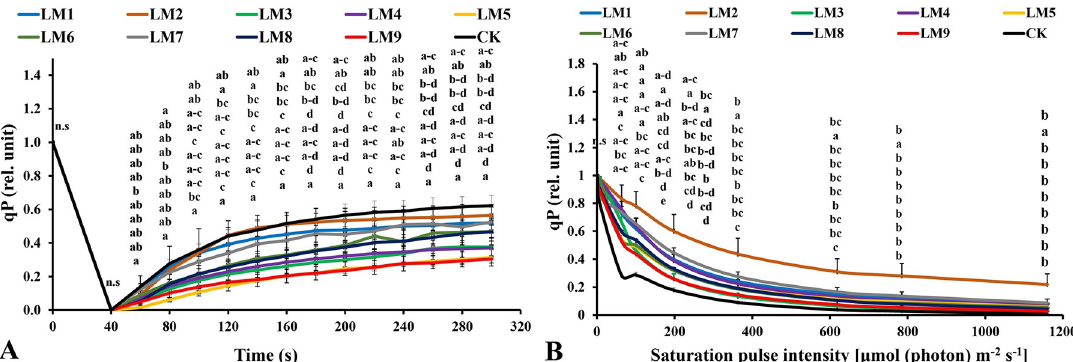
Fig 10. Effects of LED light modes on chlorophyll a fluorescence induction kinetics of the dark-acclimated (A) and RLC of the light- acclimated (B) of photochemical quenching coefficient (qP) in rocket leaves. The points are means ± SE of 4 replicates followed by the same letters meaning no different significantly according to the Duncan test (P � 0.05). Sort significance letters from top to bottom according to the treatments (ML1-CK). LM1 = A1:B1:C1, LM2 = A1:B2:C2, LM3 = A1:B3:C3, LM4 = A2:B1:C2, LM5 = A2:B2:C3, LM6 = A2:B3:C1, LM7 = A3:B1:C3, LM8 = A3:B2:C1, LM9 = A3:B3:C1, CK = White fluorescent light.